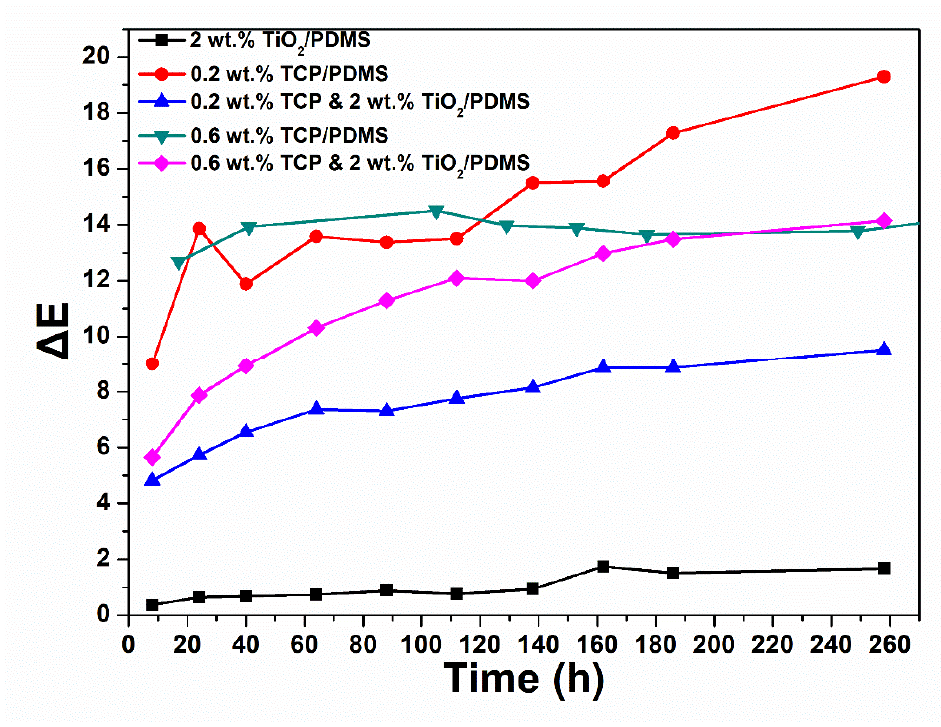
Figure 10. The total color change ∆ E as a function of time, during accelerated aging of silicone elastomers colored with TCP (0.2 and 0.6 wt%). Table 8. DSC results of 2 wt% TiO 2 /PDMS nanocomposite after 258 h exposure to accelerated aging, in comparison with unexposed (reference)